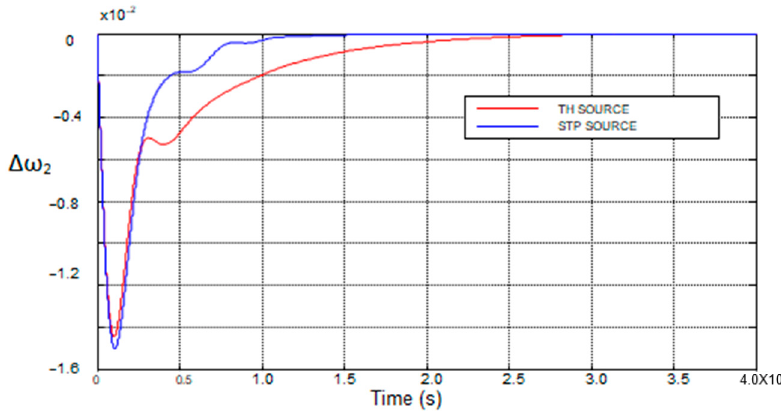
Figure 7. Changes in frequency in area 1 without and with STP (SLP two percent).